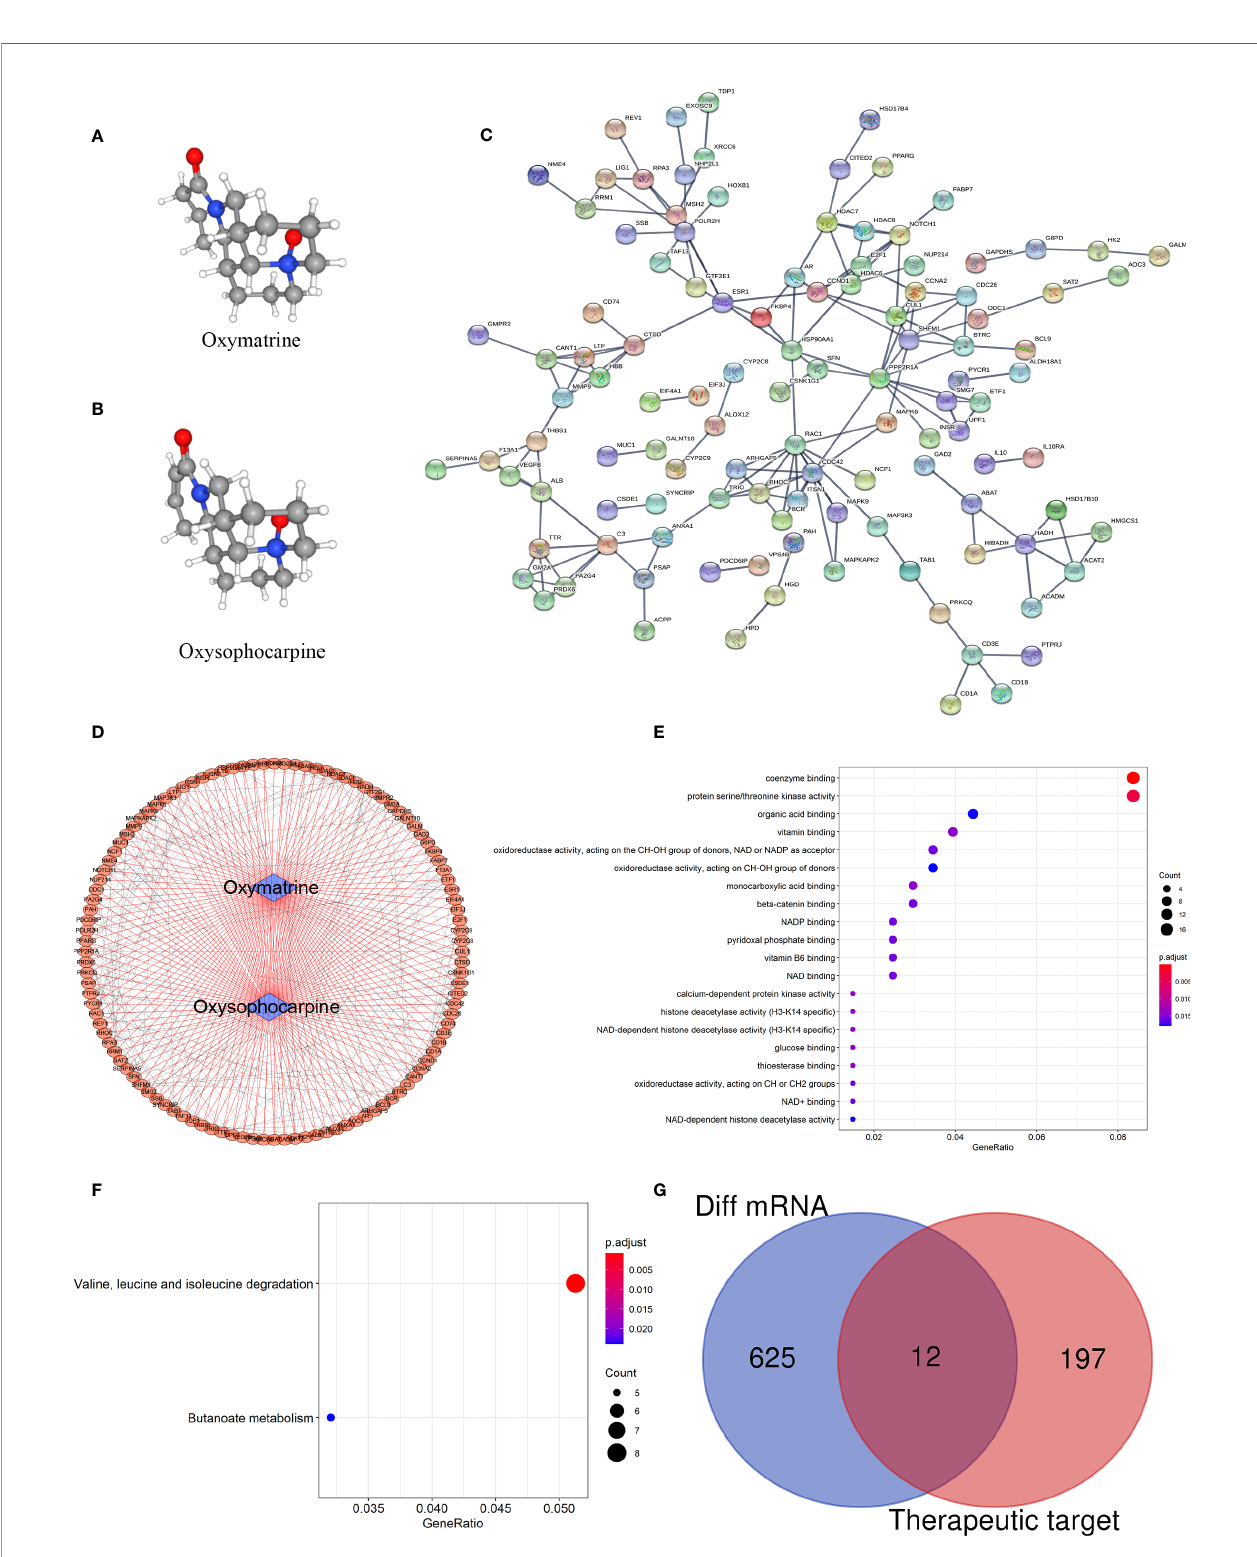
FIGURE 5 | Target gene prediction of matrine and mechanism of matrine to MS. (A, B) 3D structure of oxymatrine and oxysophocarpine. (C, D) PPI network of target genes. (E) Top 20 GO function analysis of target genes. (F) KEGG signaling pathways of target genes. (G) Venn diagram of DEGs among MS and control brain tissues (the blue part) and target genes of matrine (the red